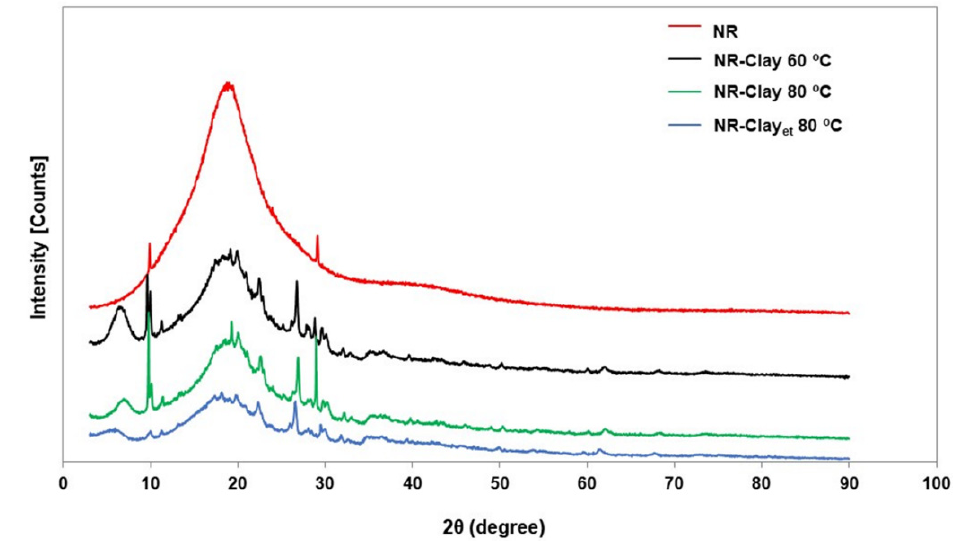
Figure 3. XRD pattern of NR, NR-Clay composites at various mixing temperatures (60 ° C, 80 ° C) and NR-Clay composites using Et-OH dispersed bentonite clay.